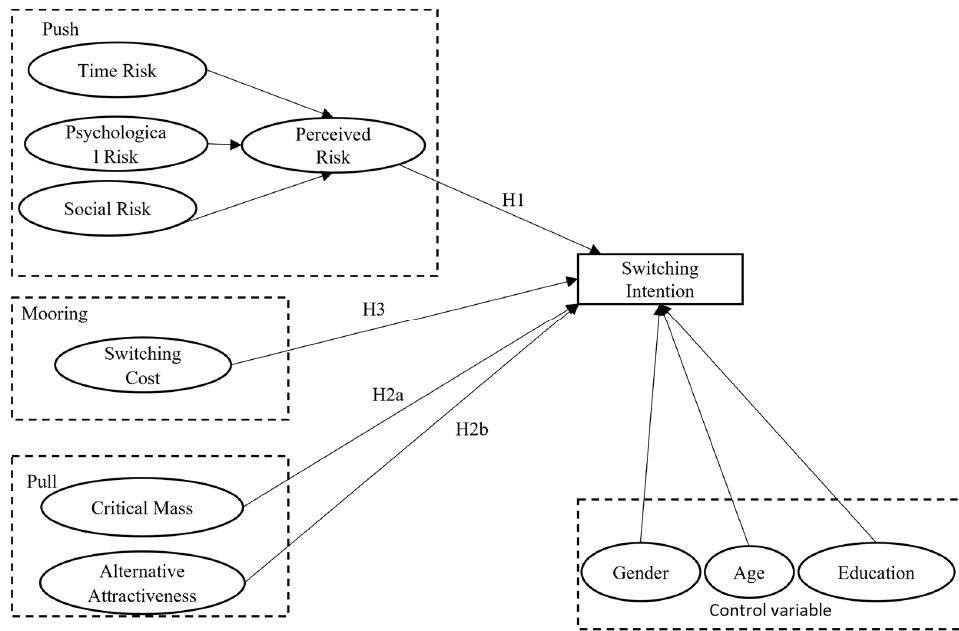
Figure 1. Research